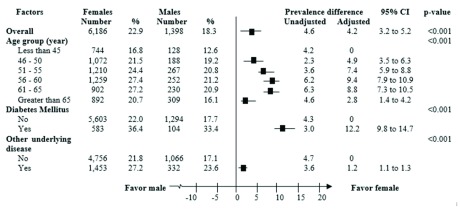
Adjusted prevalence differences of nonalcoholic fatty liver disease between women and men stratified by age group and underlying diseases.Each was adjusted for all others.